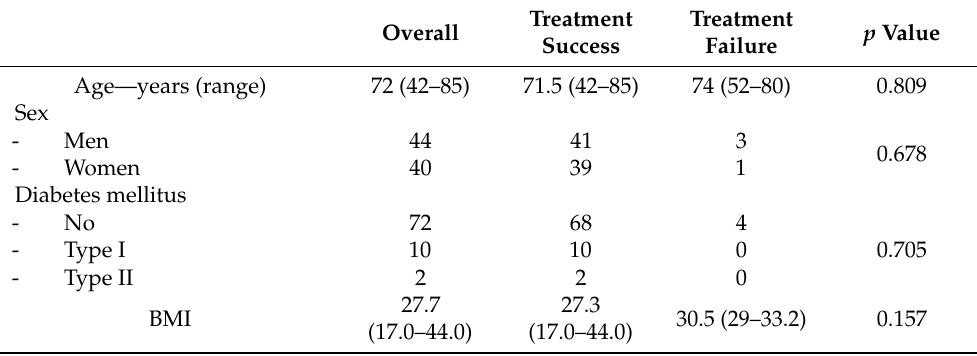
Table 1. Patient demographics and clinical